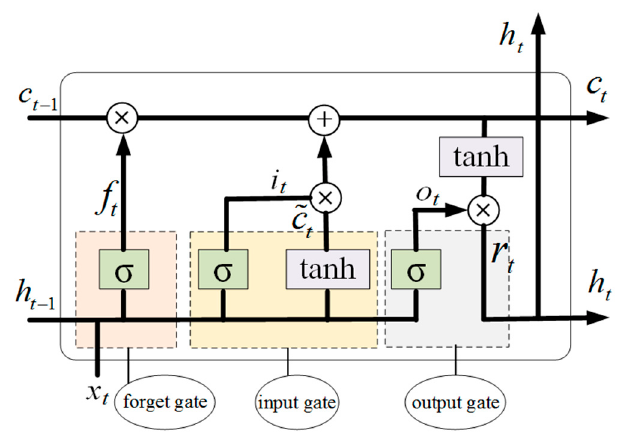
Figure 1. Typical structure of LSTM.